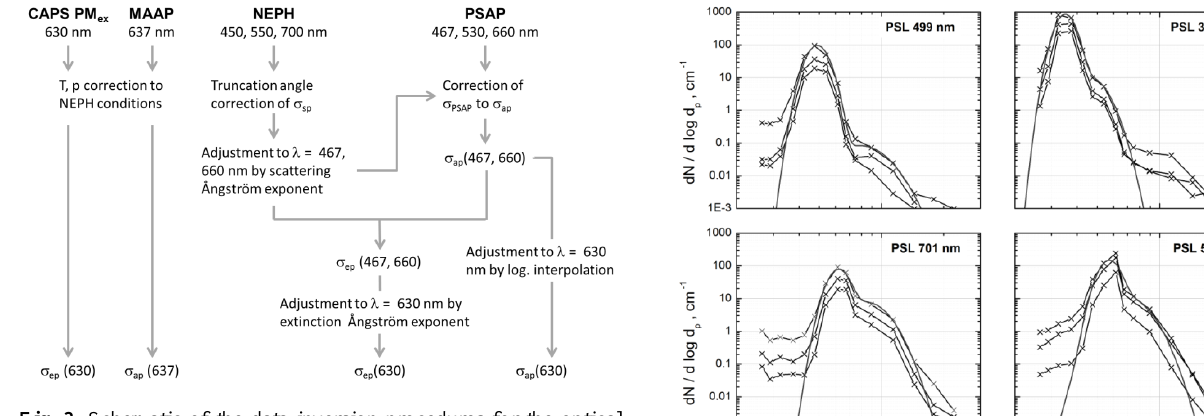
Figure 4. Number size distributions of PSL spheres measured downstream of the DMA; grey lines represent bimodal log-normal size distributions representing PSL and PSL conglomerates. Nominal sizes of atomized PSL standards are indicated.